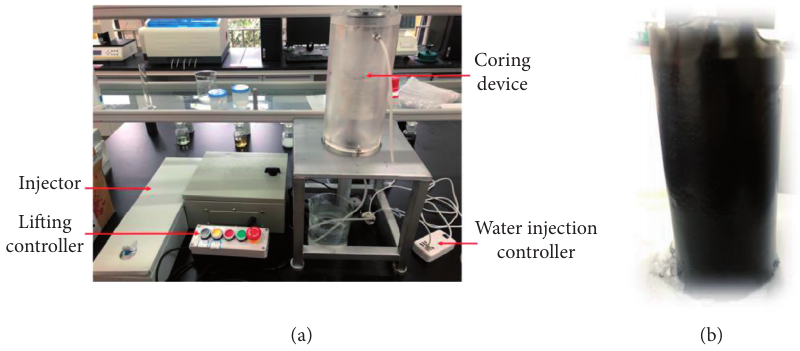
Figure 13: Photograph of (a) quality-preserving coring simulator and (b) core covered with sealing film.